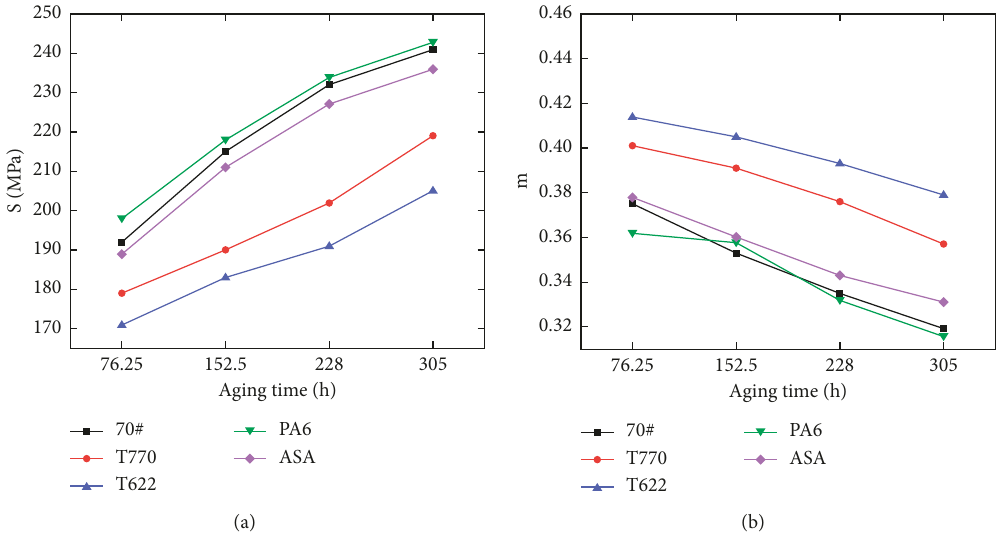
Figure 13: BBR bending beam rheological test results. (a) The relationship between the creep modulus S and aging time of different kinds of asphalt. (b) The relationship between the creep rate m and aging time of different kinds of asphalt.